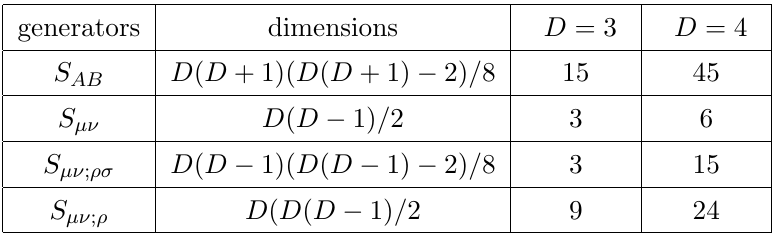
Table 2 . Lorentz